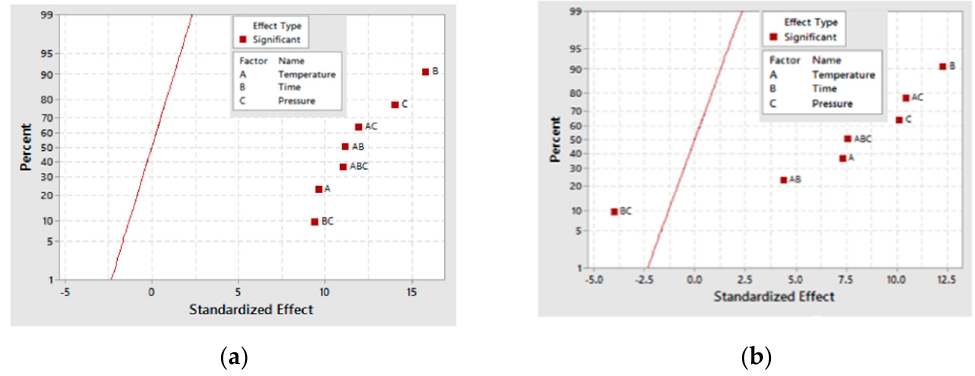
Figure 4. Half-normal plot for glyceric acid production for ( a ) the 30-min and ( b ) the 60-min as-deposited electroless CuNiMoP/Al 2 O 3 oxidation reactions.